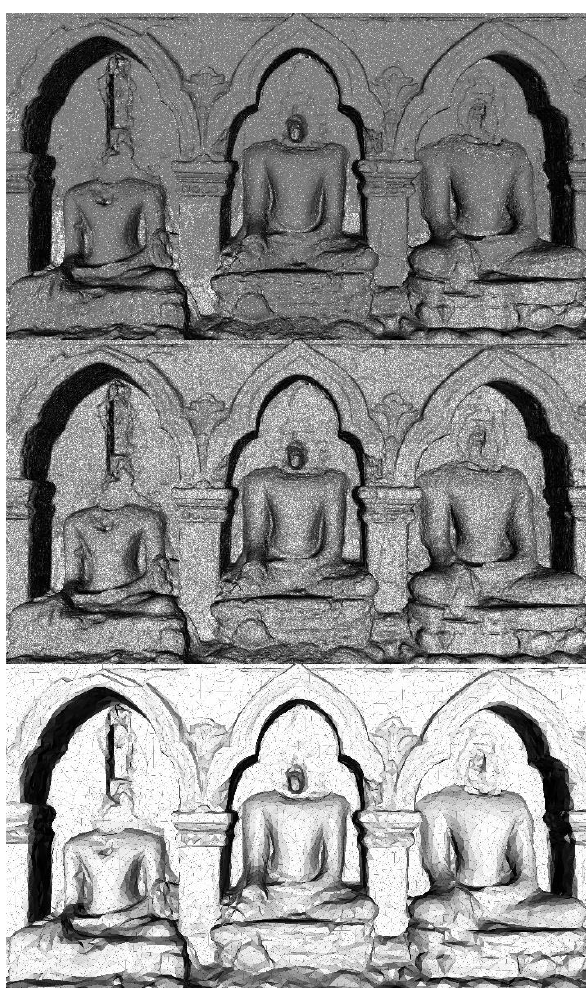
Figure 3. The different stages of decimation applied to a piece of the Myin-pya-gu model: 44 million polygons (top), 12 million polygons (middle), 60 thousand polygons (bottom)